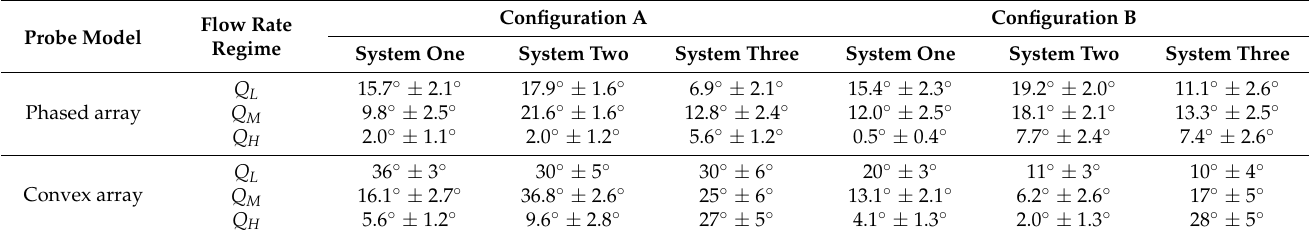
Table 9. Blind angle parameter results (mean ± SD).